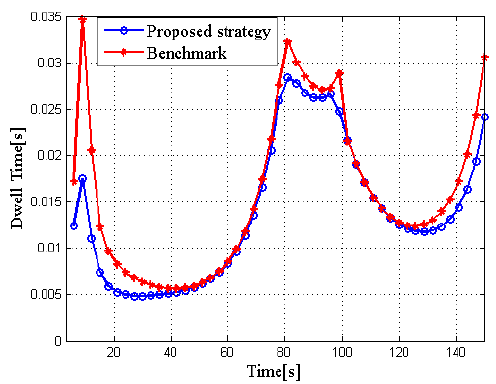
Figure 5. Comparison of total dwell time for different algorithms in RCS case 1.